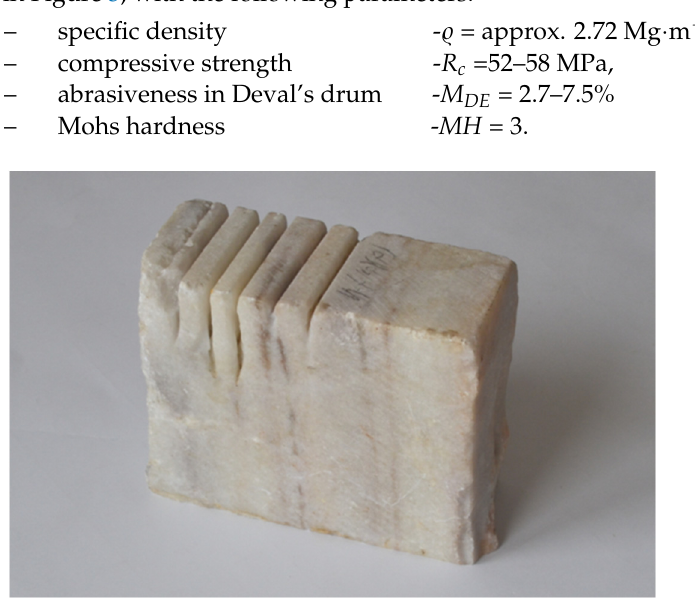
Figure 3. Marble from White Marianna quarry.